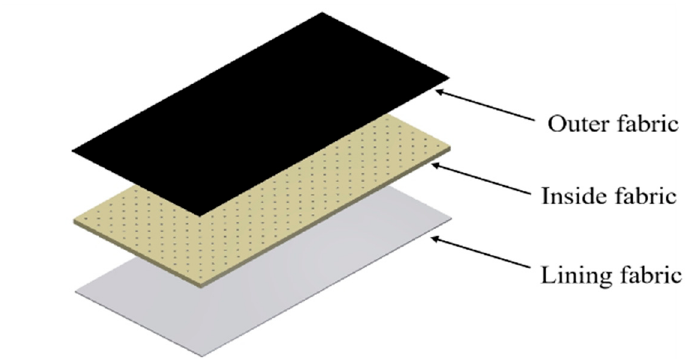
Figure 1. Ski jumping suit